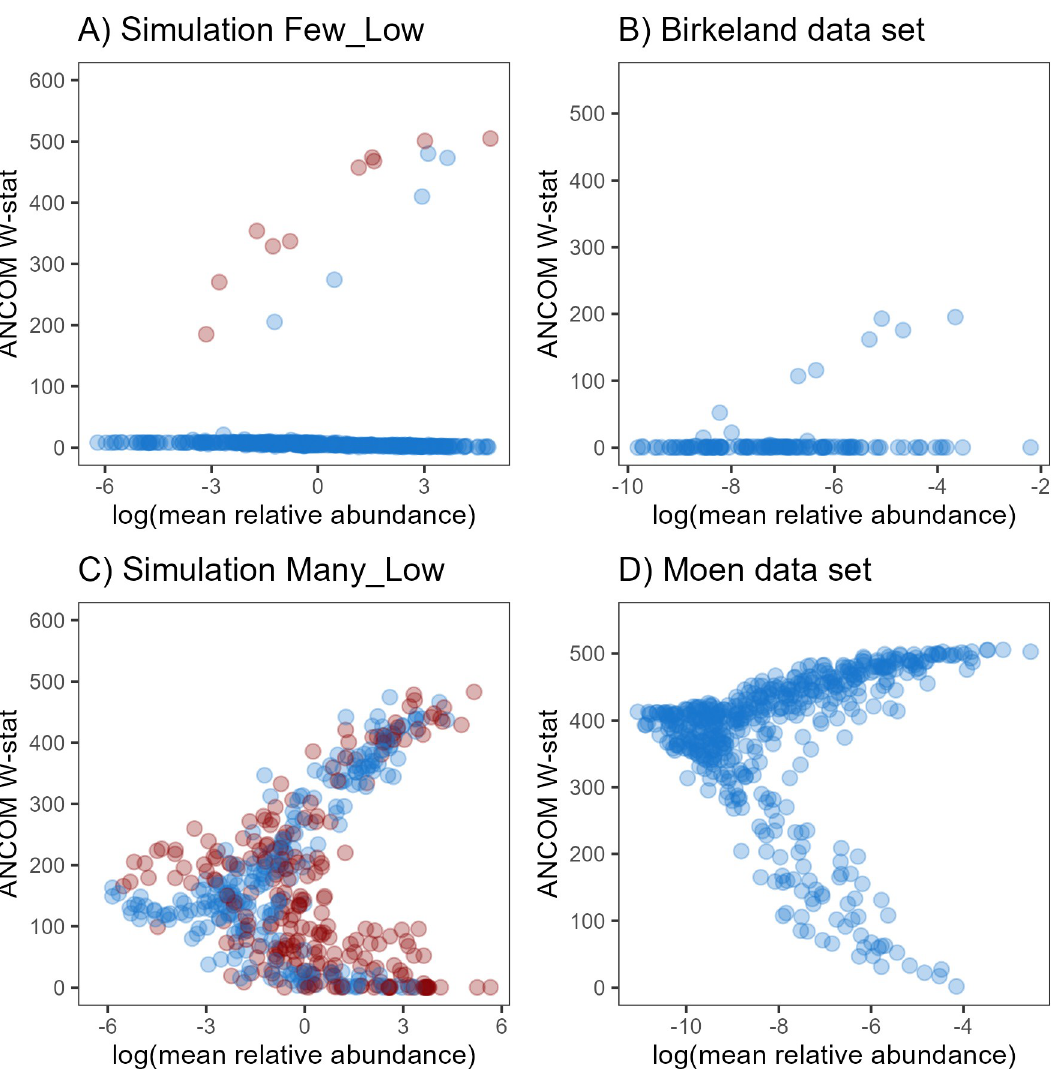
Fig 5. Mean relative abundance (log-scale) plotted versus ANCOM W-stat. (A) The “Few-Low” simulation scenario and (B) Birkeland data set, (C) “Many-Low” simulation scenario and (D) Moen data set. Red points (panels A and C) indicate differentially abundant